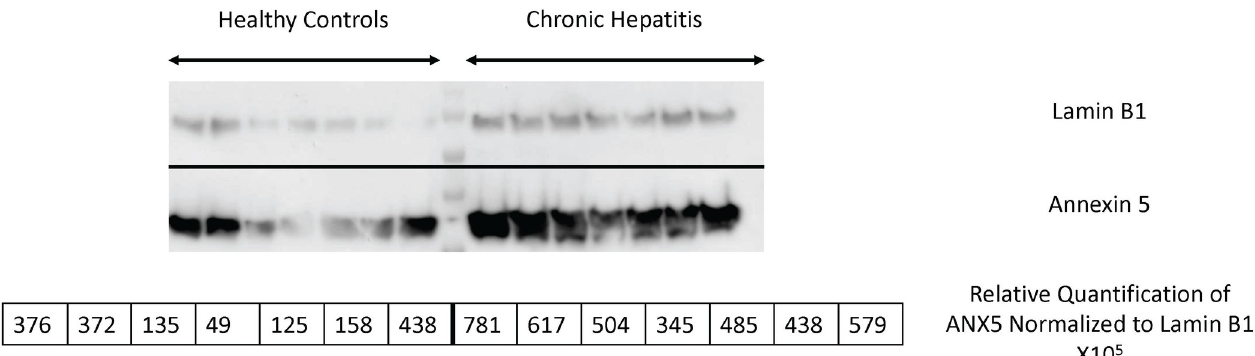
Fig 2. Relative abundance of annexin 5 in the hepatic tissue of dogs with chronic hepatitis by Western blot analysis. Annexin 5 was assessed in the liver proteome of 7 dogs with chronic hepatitis and compared to 7 healthy control dogs. Lamin was used as a loading control.